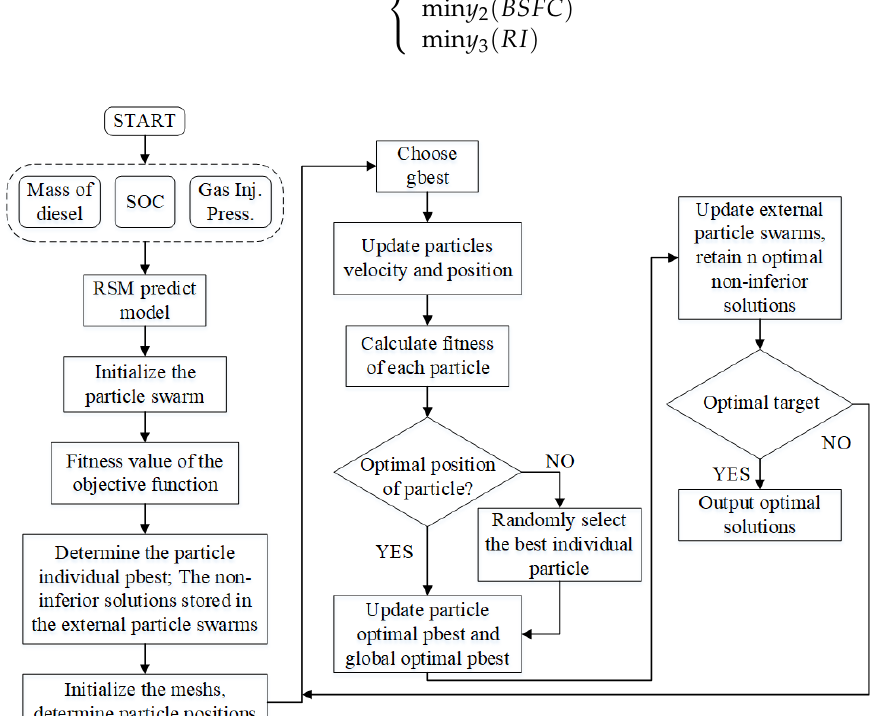
Figure 11. MOPSO optimization flow chart.